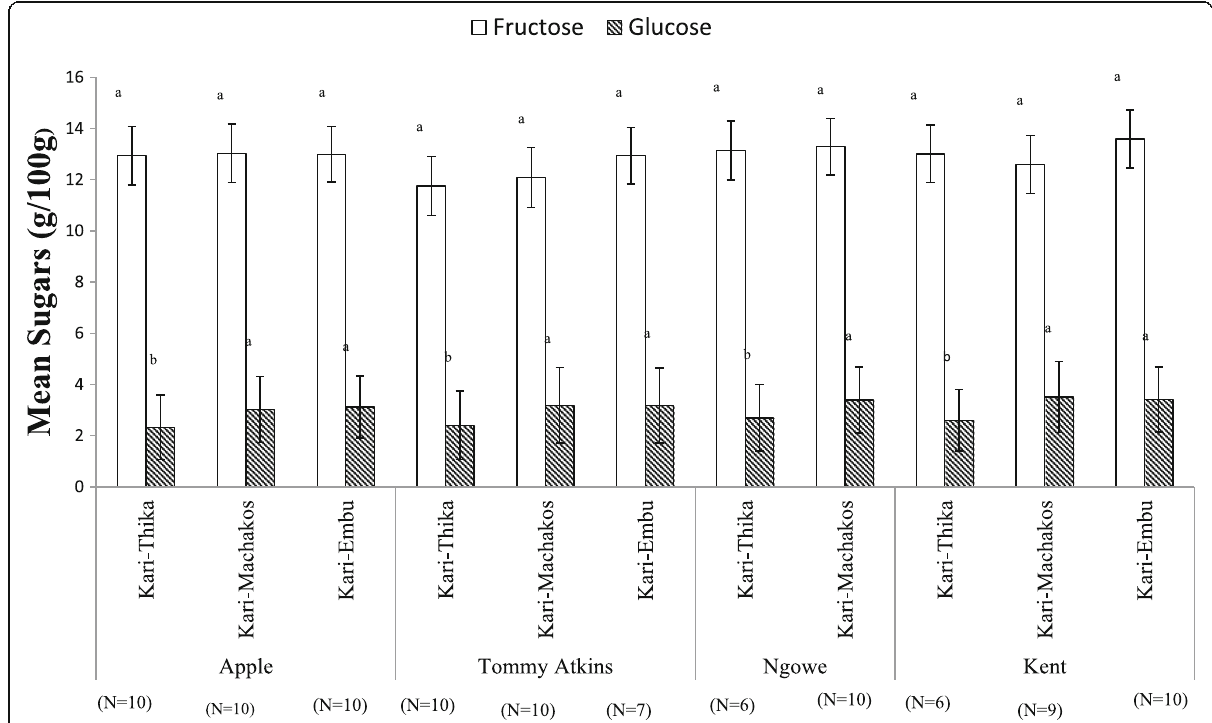
Fig. 5 General trend of changes in mean fructose ( a ) and glucose ( b ) contents of mango cultivars at different ripening stages in KARI-Thika